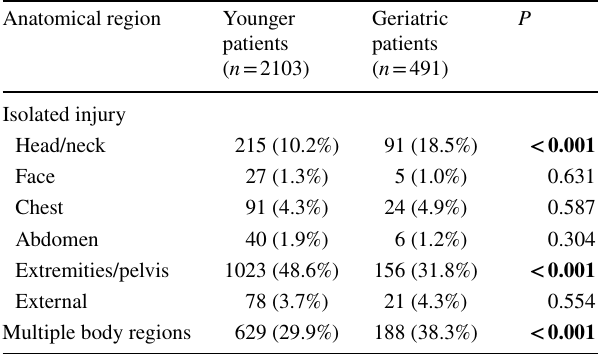
Bold values indicate the level of statistical significance was P <